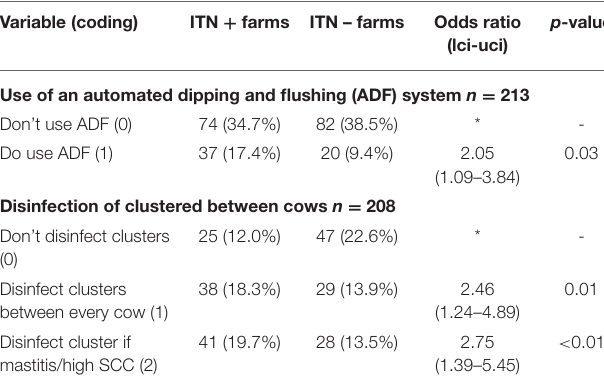
TABLE 2B | Univariable “chemical” factors associations with ischaemic teat necrosis (ITN) as the outcome variable. Variable (coding) ITN + farms ITN –